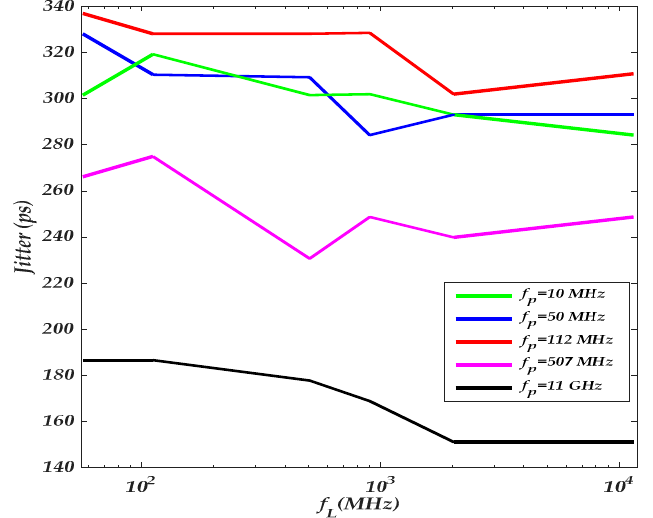
Figure 12. Parametric plot of the driver’s jitter TF as the last-stage frequency is swept for different sinusoidal tone excitation of the pre-driver stage.